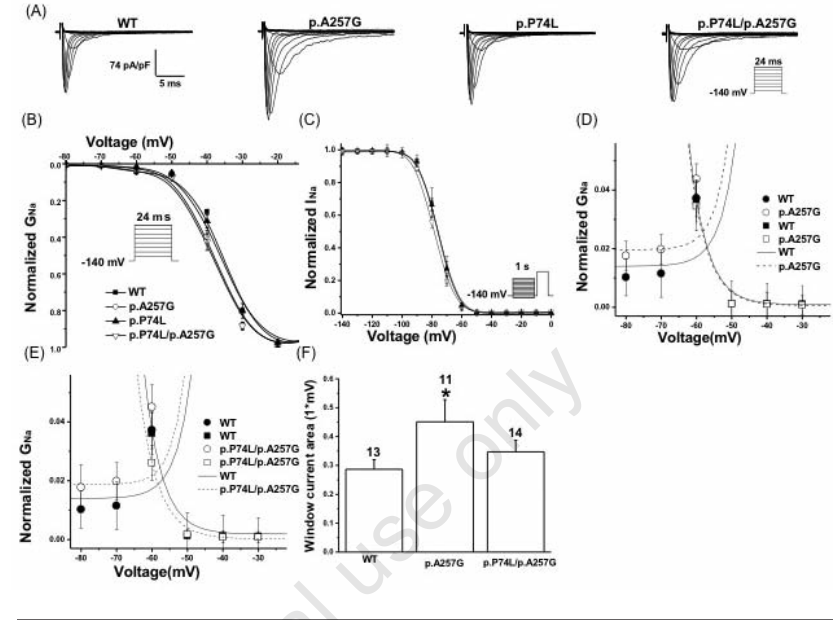
Figure 1. Co-transfection of SNTA1 with SCN5A. A) Representative whole-cell current traces of HEK293 cells co-expressing WT or mutant SNTA1 and SCN5A, showing increased peak I for p.A257G-SNTA1. The currents were recorded at membrane poten- Na tials between -120 to +60 mV in 10-mV increments from a holding potential of -140 mV as depicted in the protocol inset. B) Activation was measured using this protocol: currents were elicited by step depolarization for 24 ms to different potentials between –120 mV to 60 mV from a holding potential of -140 mV. The curves were fit with a Boltzmann func- tion where G = [1+exp (V - V) / K ] -1 , where V and k are the midpoint and slope fac- Na 1/2 1/2 tor, respectively. G/G = I (norm)/ (V - Vrev) where Vrev is the reversal potential and V Na Na is the membrane potential. p.A257G- and p.P74L/p.A257G-SNTA1 mutations caused a statistically significant hyperpolarizing shift in steady-state activation by 2.1-2.7 mV. C) Steady-state availability from inactivation was measured using the protocol shown in the inset and was determined by fitting the data to the Boltzmann function: I = I Na Na-Max [1+exp (Vc - V ) / K ] -1 , where V and k are the midpoint and the slope factor, respec- 1/2 1/2 tively, and Vc is the membrane potential. p.P74L/p.A257G-SNTA1 mutation had a statis- tically significant hyperpolarizing shift in steady-state inactivation by 2.6 mV. D) The peak current activation data are replotted as a conductance ( G ) curve with steady-state inactivation relationships to show p.A257G increases the overlap of these relationships (window current). E) The peak current activation data are replotted as a conductance ( G ) curve with steady-state inactivation relationships to show p.P74L/p.A257G reverses the increased overlap of these relationships. Circles indicate activation, whereas squares indi- cate inactivation. Lines represent fits to Boltzmann equations with parameters of the fit